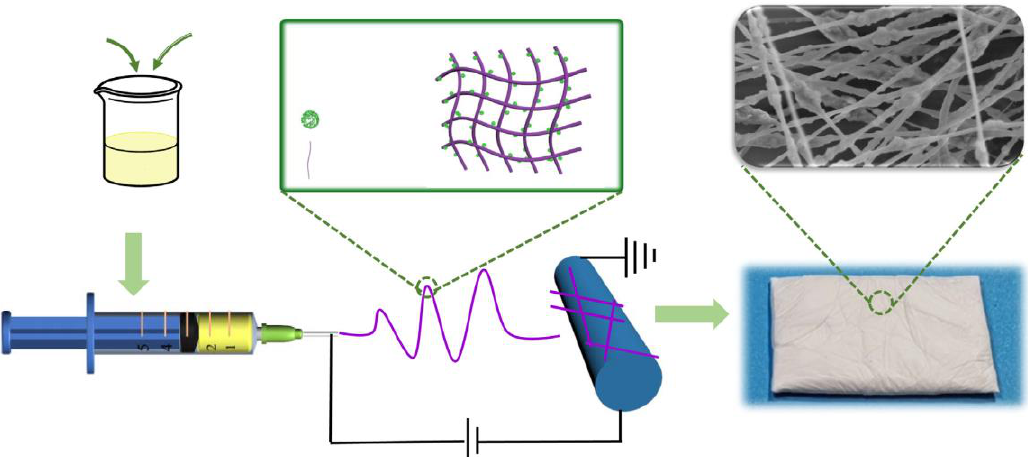
Figure 3. The schematic and images of SiO 2 aerogel modified polyacrylonitrile nanofiber membranes. Reprinted with permission from [11]. Copyright © 2020 Elsevier B.V.